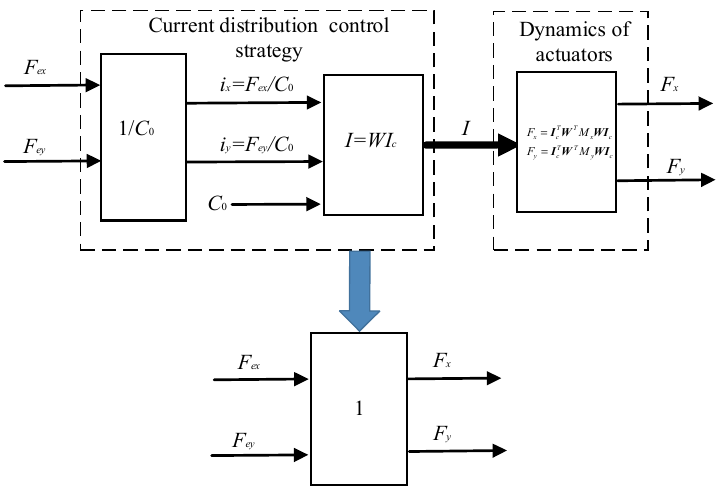
Figure 3. Block diagram of the existing current distribution control strategy.